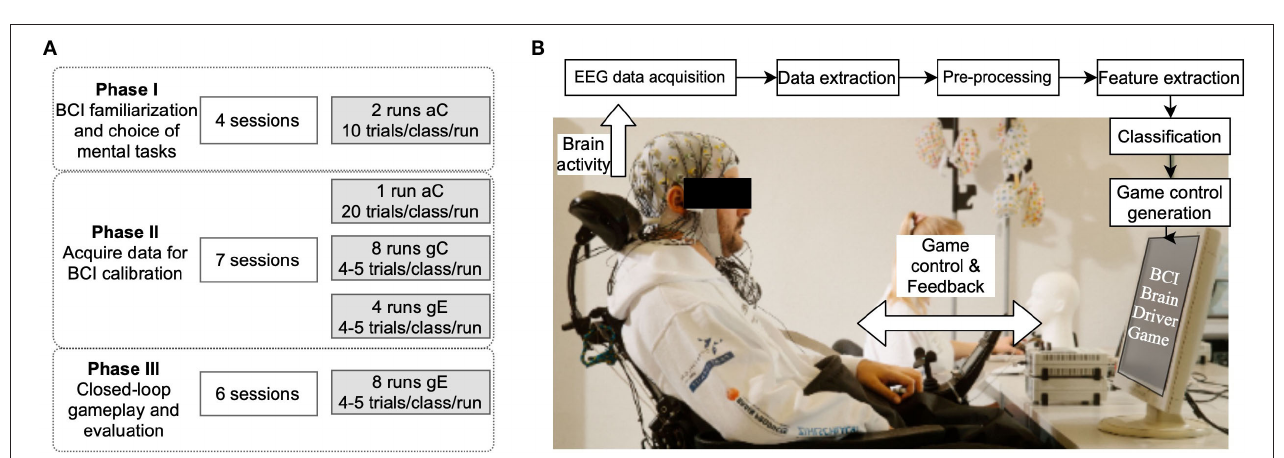
FIGURE 2 | Overview of experiment. (A) Strategy: summary of the training sessions that were analyzed in preparation to participate in Cybathlon. The objective of each experiment phase is indicated along with the number of experiment runs across the training sessions. (B) Setup: BCI facilitates a closed-loop interaction between the pilot and the game interface. The brain activity generated by the pilot as he performs mental tasks are translated to commands to control the movement of a virtual avatar in the